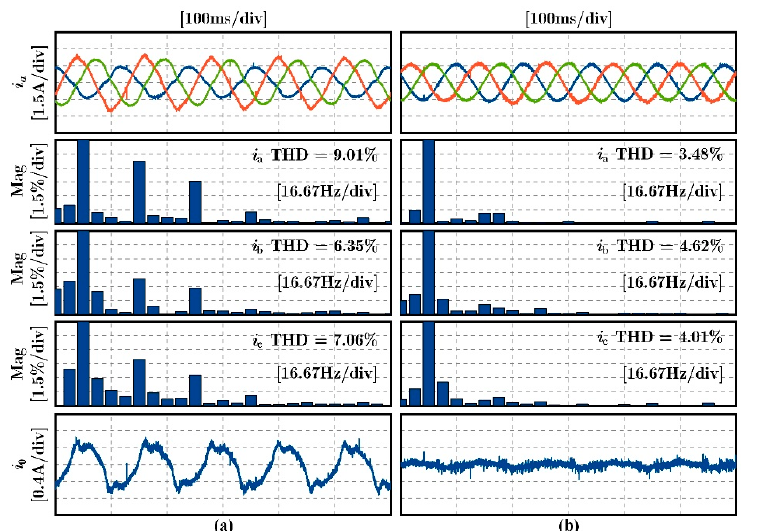
Figure 17. Experimental performance under 100 r/min: ( a ) comparison scheme (without zero-sequence loop control); ( b ) proposed scheme (with zero-sequence loop control).